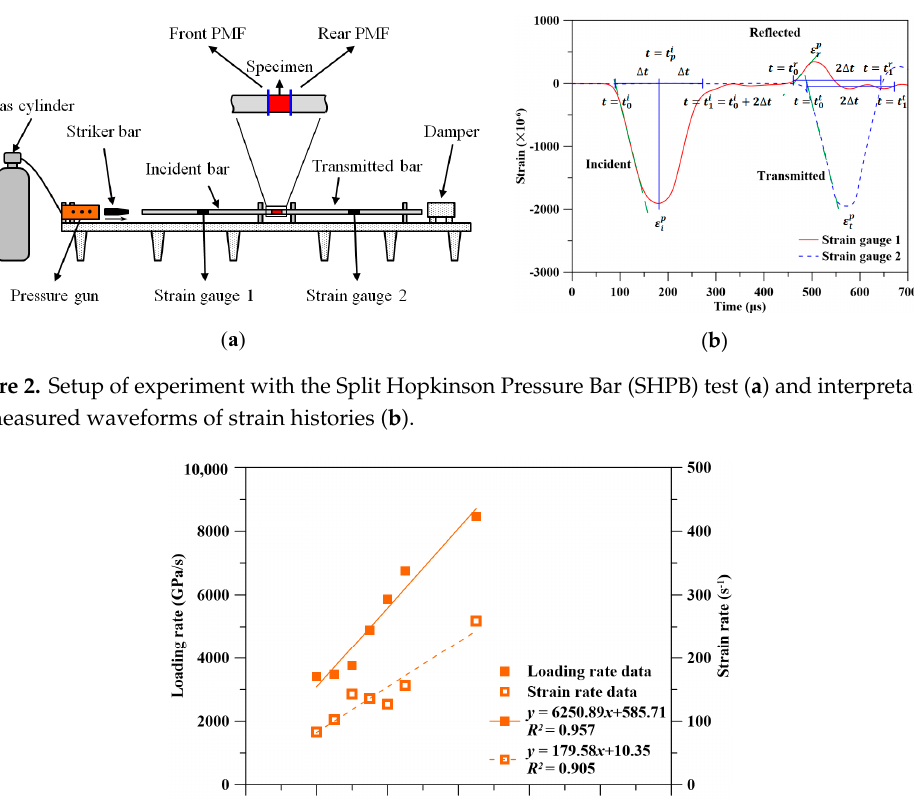
Figure 3. Relationship between pressure of gas chamber when striker bar is released and loading rate.